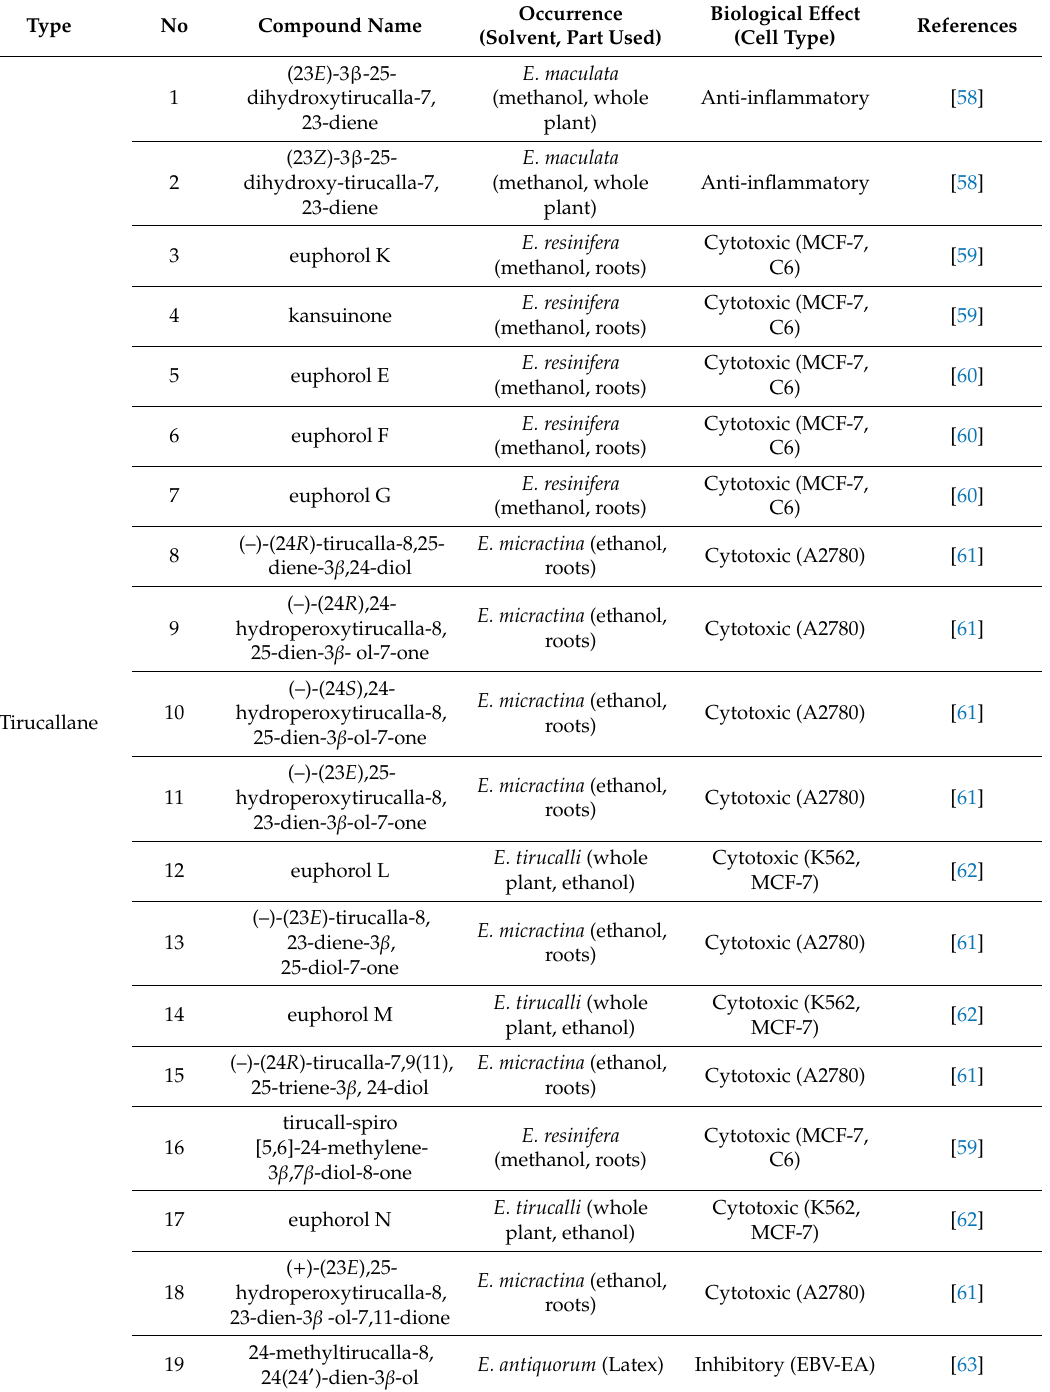
Table 2. Triterpenoids isolated from the genus